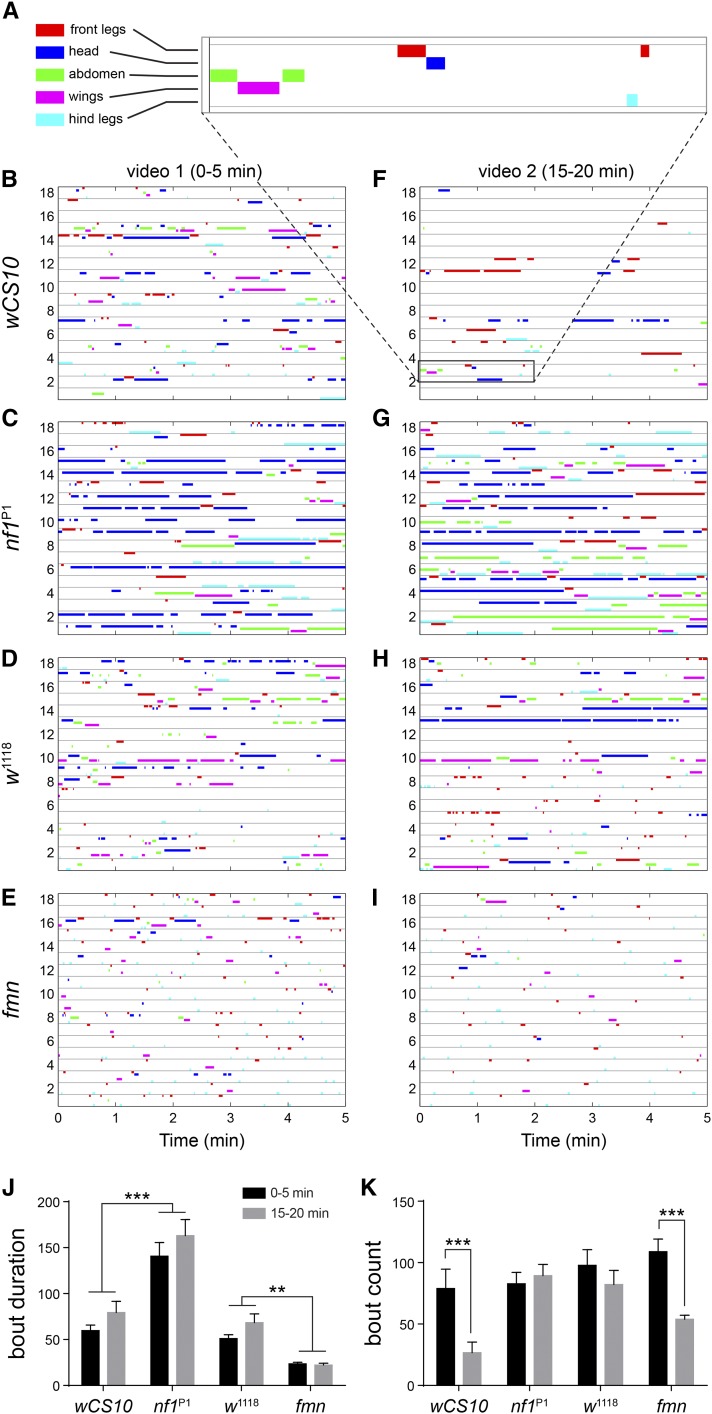
Ethograms of nf1P1 and fmn mutants. (A) Expanded view of a 2 min time segment, with the legend showing color coding for grooming behaviors. (B)–(I) Ethograms of flies of the following genotypes: wCS10, nf1P1, w1118, fmn. Two points are shown: 0–5 min, and 15–20 min. Data are from the same flies as in Figure 5. (J) Duration of individual grooming bouts, in frames, for each genotype and time point. Bars and whiskers represent mean ± SEM. ** P < 0.01, *** P < 0.001 (ANOVA/Sidak). (K) Number of grooming bouts for each genotype and time point. *** P < 0.001 (ANOVA/Sidak). There was no significant difference across genotypes for the 0–5 min videos.